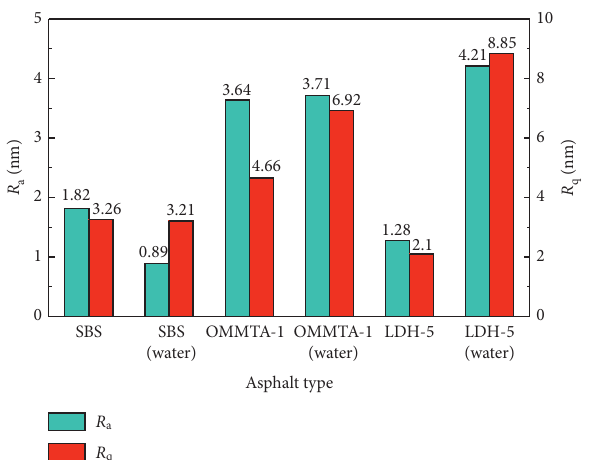
Figure 10: Roughness variation for the three types of asphalt before and after immersion.